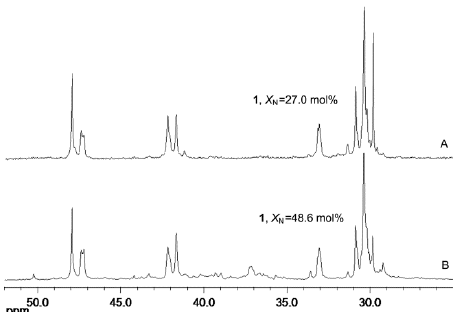
Figure 6. 13 C NMR spectra of the polyethylenes obtained from 1 /MAO at different norbornene additions (entries 1 and 5 in Table 2).